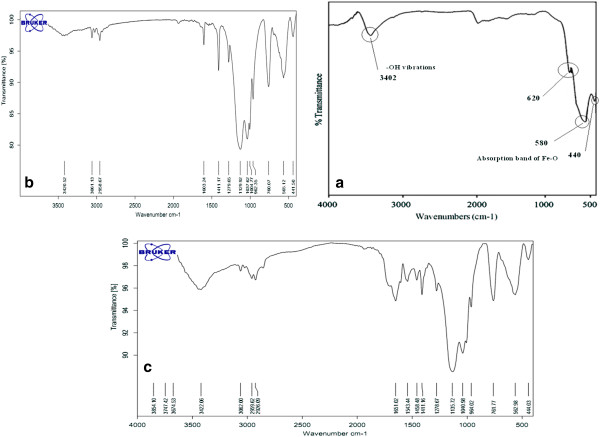
FT-IR spectra of (a) pure Fe3O4 nanoparticles, (b) Fe3O4 nanoparticles modified by VTES, (c) poly(NIPAAm-MMA)-grafted Fe3O4 nanoparticles.